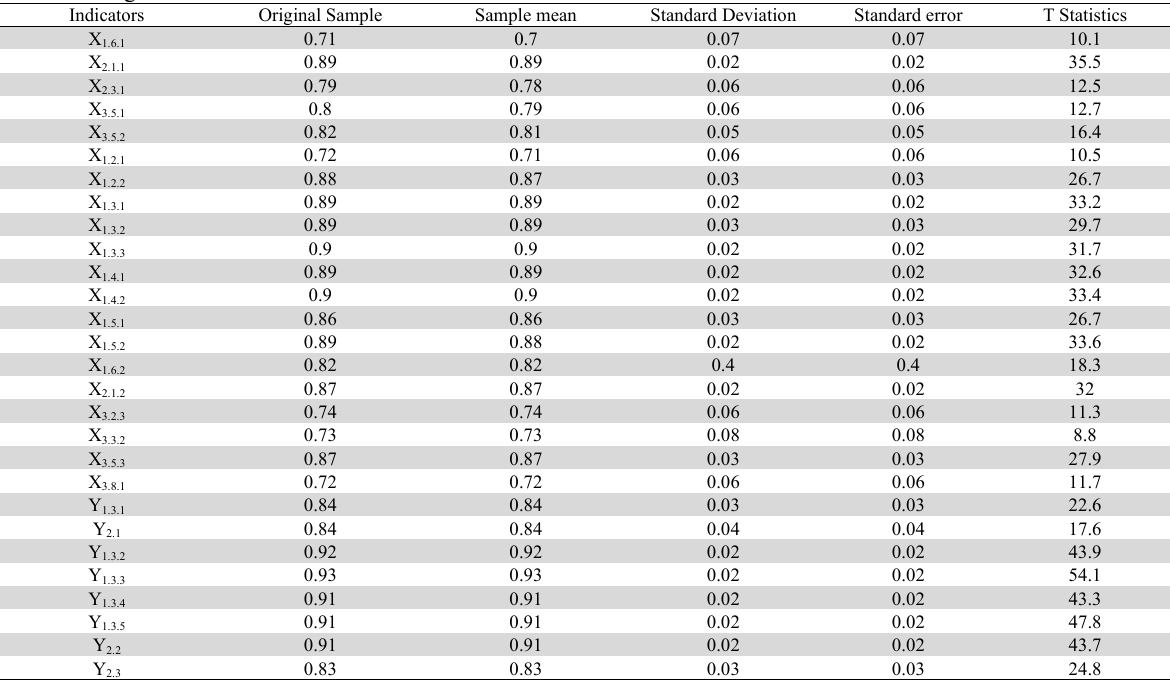
Table 1 Outer Loading Value after